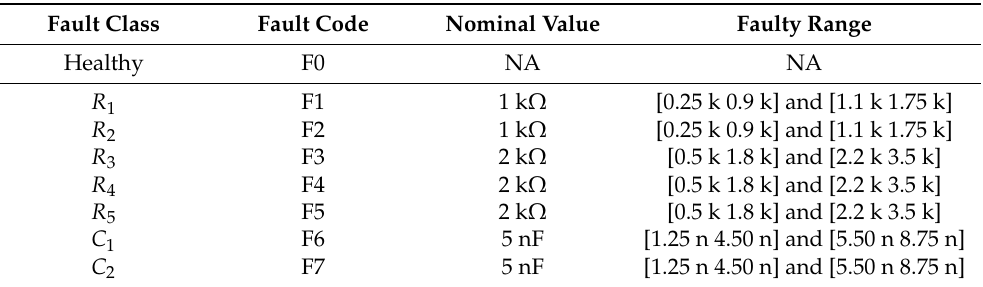
Figure 4. Sallen–Key bandpass filter. Table 2. Nominal values and parametric fault range of Sallen–Key bandpass filter components.